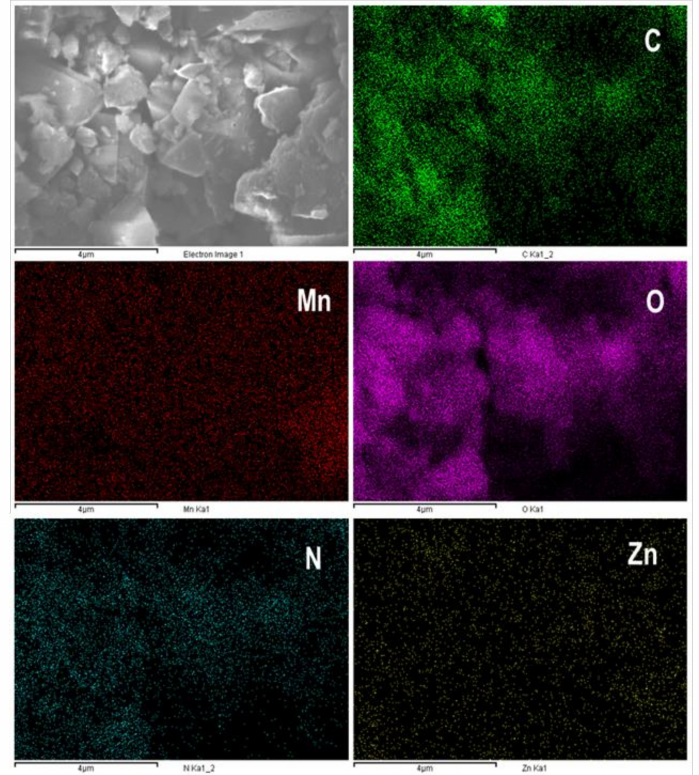
Figure 6. Elemental mapping of (1%) ZnO–MnCO 3 /(1%-NDG) nanocomposite.